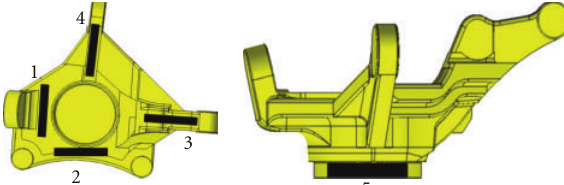
Figure 27: Positions of sample to observe in microstructure.